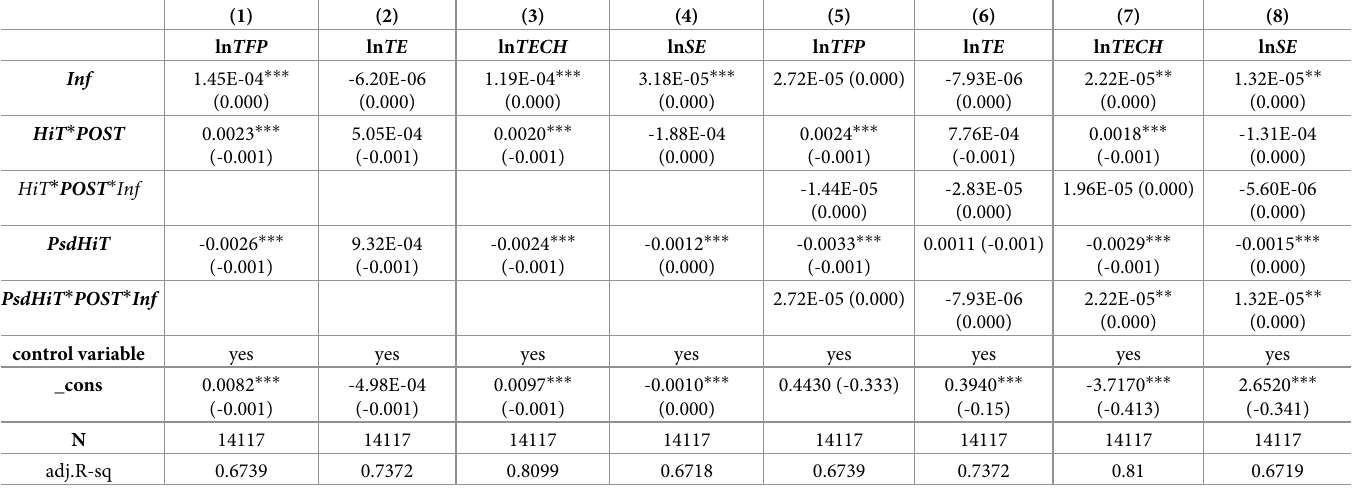
Table 6. The moderating effect of IA on the sustainable development of "True" and "Fake" digital